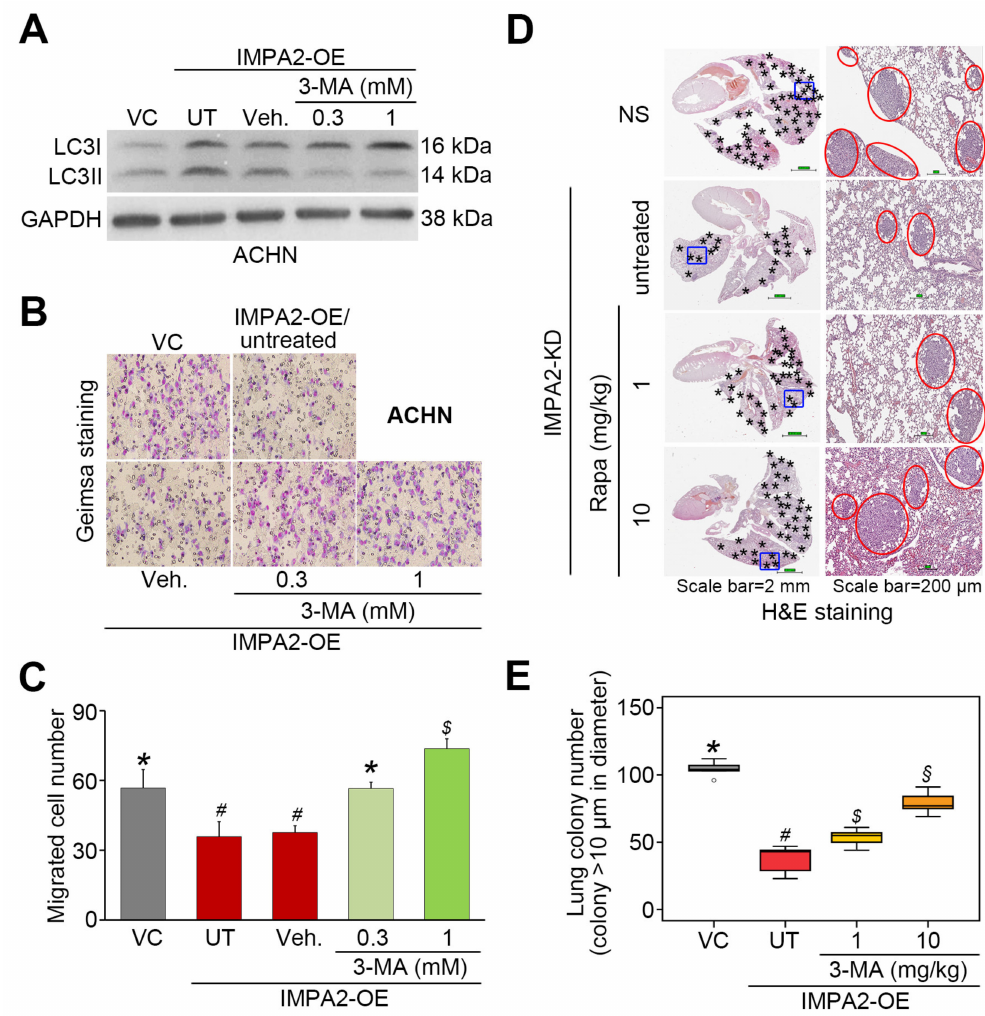
Figure 5. The inhibition of autophagy initiation by 3-MA rescues the metastatic potential of the IMPA2-overexpressing ACHN cells in vitro and in vivo. ( A ) The results from the Western blot analysis for the LC3-I / II and GAPDH proteins derived from ACHN cells without (VC) or with G α h overexpression (OE) in the absence (untreated, UT) or presence of solvent control (vehicle, Veh.) or the autophagy inhibitor 3-MA (0.3 or 1 mM). ( B and C ) Giemsa staining ( B ) and cell number ( C ) of the migrated ACNH cell variants (purple staining) shown in A. Data obtained from three independent experiments are presented as the mean ± SEM. Di ff erent symbols *, # and $ indicate the significant di ff erences at p < 0.01 analyzed by the nonparametric Friedman test. ( D and E ) H&E stained lung tissues ( D ) and the number of lung tumor colonies ( E ) derived from the mice transplanted with ACHN cell variants, shown in A, through tail vein injection for 4 weeks. The symbol “*” indicates the size of tumor colonies over than 200 µ m in diameter. Tumors are shown in red circles. Statistical significance was analyzed by the nonparametric Kruskal Wallis test. Di ff erent symbols *, #, $ and § in each column indicate the statistical significance at p <